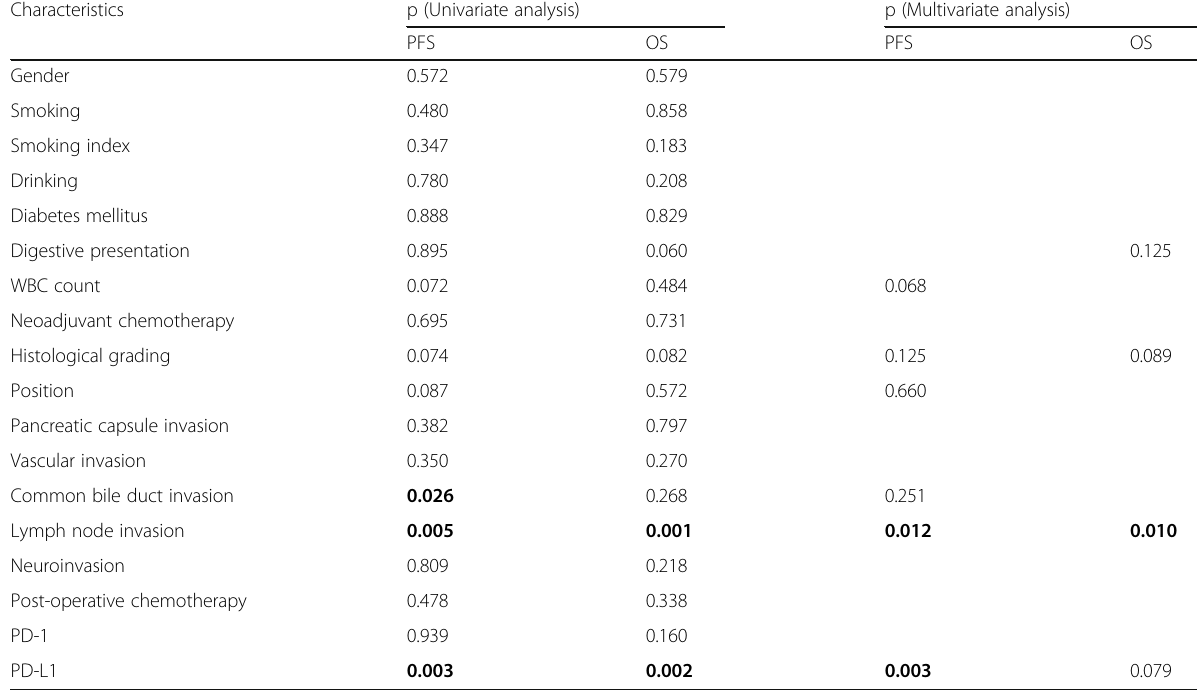
Table 2 Univariate and multivariate analyses of prognostic factors for PFS and OS Characteristics